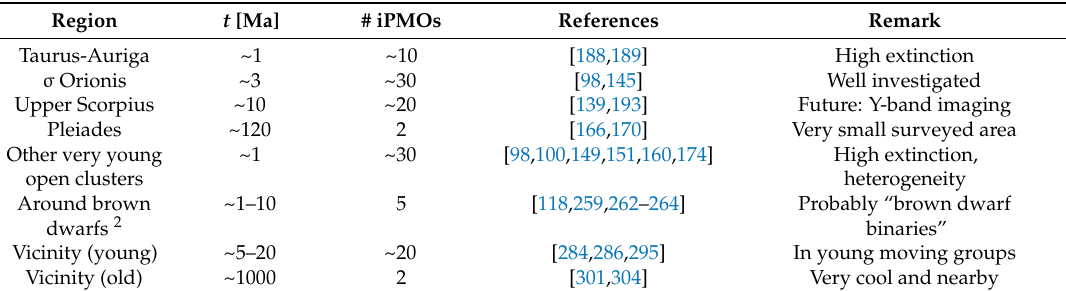
Table 2. Approximate number of iPMO candidates with spectroscopic follow-up per region 1